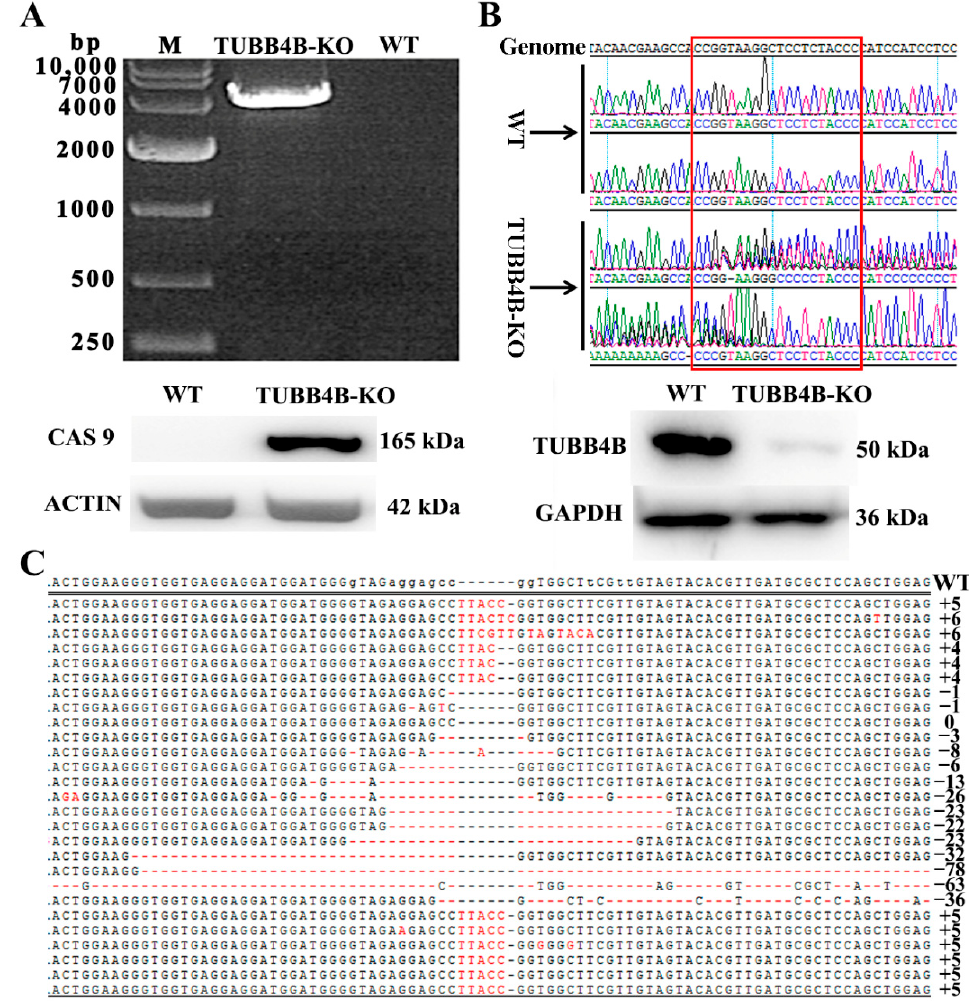
Figure 3. Detection of Tubb4b knockout in mouse spermatogonia. ( A ): RT-PCR detection of Cas9 gene expression ( Top ), and western blot detection of CAS9 protein expression in control and TUBB4B-KO mouse spermatogonia ( Bottom ); ( B ): The results of genome sequencing analysis a (Top), and western blot detection of TUBB4B protein expression in control and TUBB4B-KO mouse spermatogonia (Bottom); ( C ): TUBB4B-KO mouse spermatogonia Tubb4b -KO efficiency analysis (92.3%). Note: WT represents the control group of control mouse spermatogonia, and TUBB4B-KO represents the test group of TUBB4B-KO mouse spermatogonia, same below. M means marker. The genome represents the mouse genome sequence of TUBB4B, and the red rectangle indicates the SgRNA target of Tubb4b in ( B ). The right-hand numbers in ( C ) represent the bases of inserted or deleted, and the ‘+’ is an increase while the ‘ − ’ is a